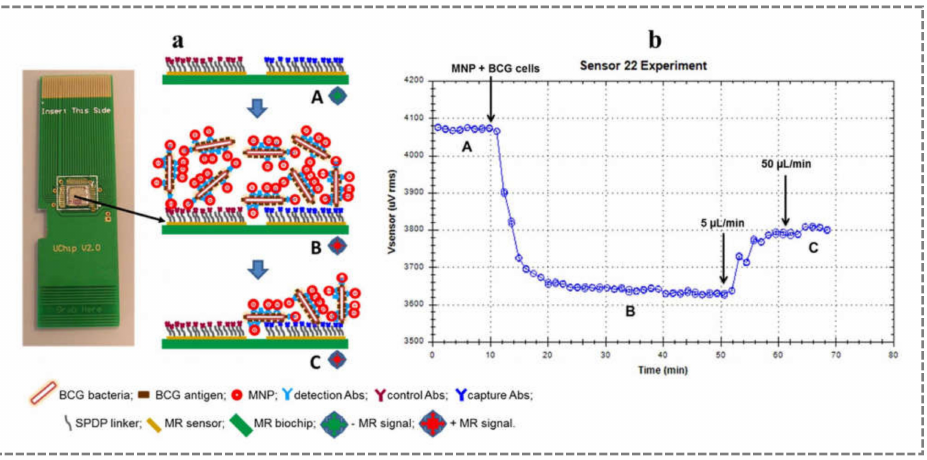
Figure 6. Image of an MR-biochip with the scheme of the sandwich-immunoassay reactions ( a ), and the corresponding average voltage variation curves over time, in the right area of the sensors whose surface was functionalised with capture antibodies ( b ): step A is the baseline or the negative MR signal (no label); then, the voltage drop is observed in step B due to positive MR signal (MNP@Abs@BCG in contact with the MR-biochip surface); and in step C, the non-bounded MNP are washed out and only the positive MR signal from labelled targets is recorded (MNP@Abs@BCG bonded to specific Abs on the biochip surface) (reproduced with permission from Barroso et al. (2018) [72], Copyright 2018, Elsevier